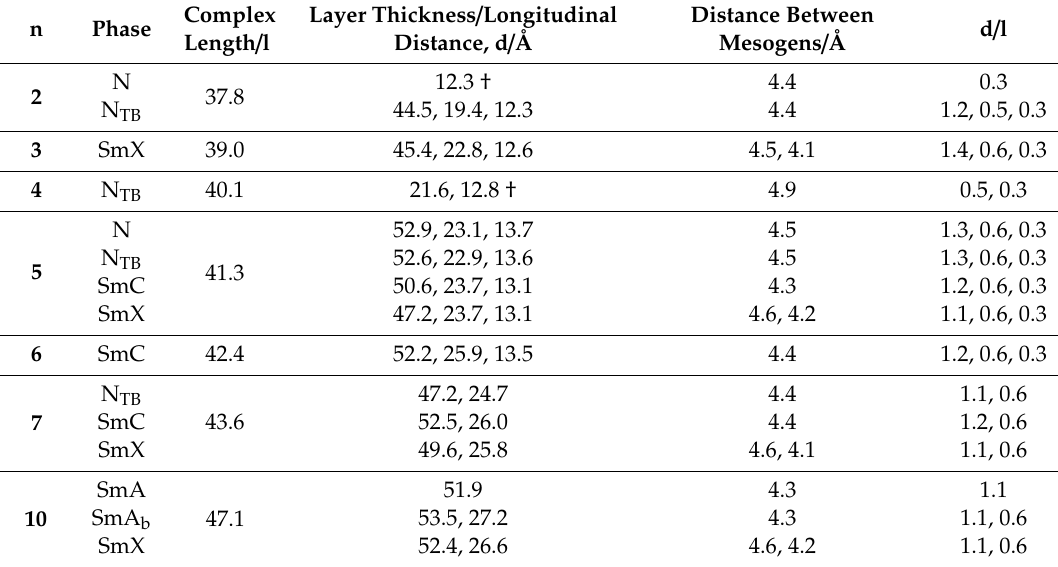
Table 2. Layer thickness (smectic phases) or end-to-end separation between molecules (nematic phases) and lateral spacing obtained from integrated X-ray di ff raction signals for the CB6OBA: n OS mixtures. For some complexes and phases, the observed pattern was too weak to determine the signal